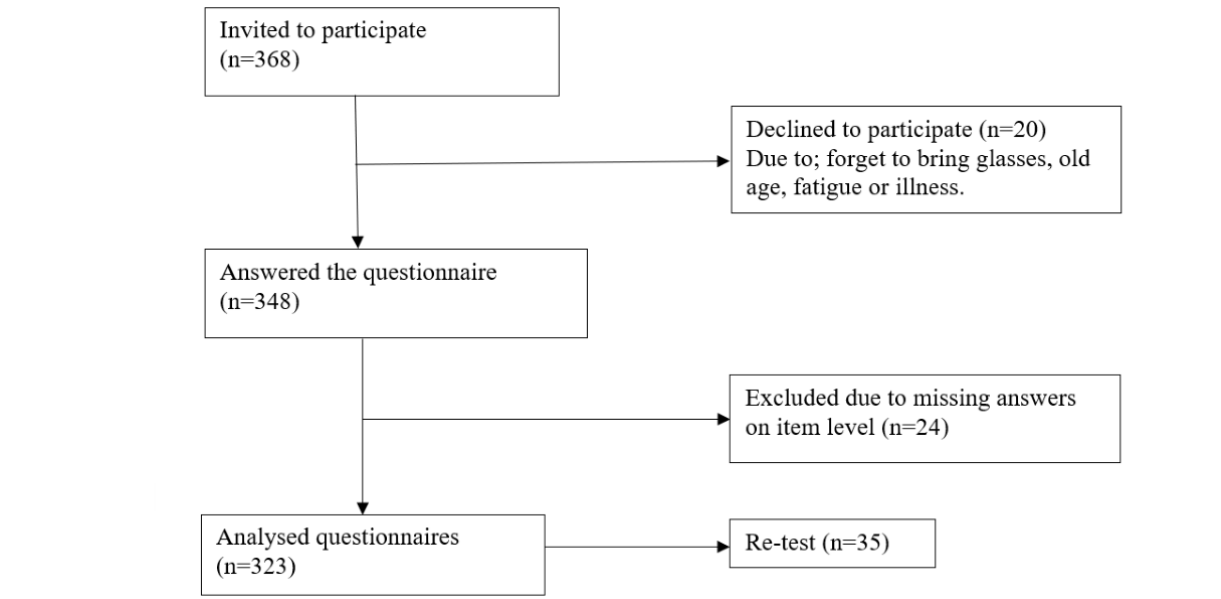
Figure 1. Flowchart of the data